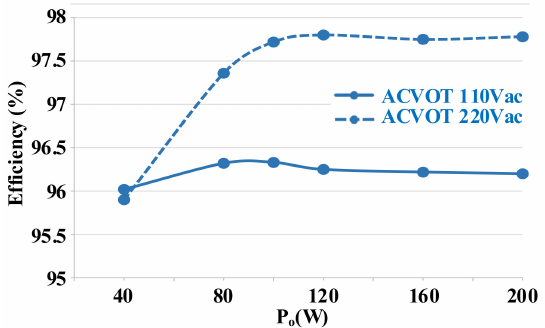
Figure 15. Measured efficiency of the prototype under the ACVOT